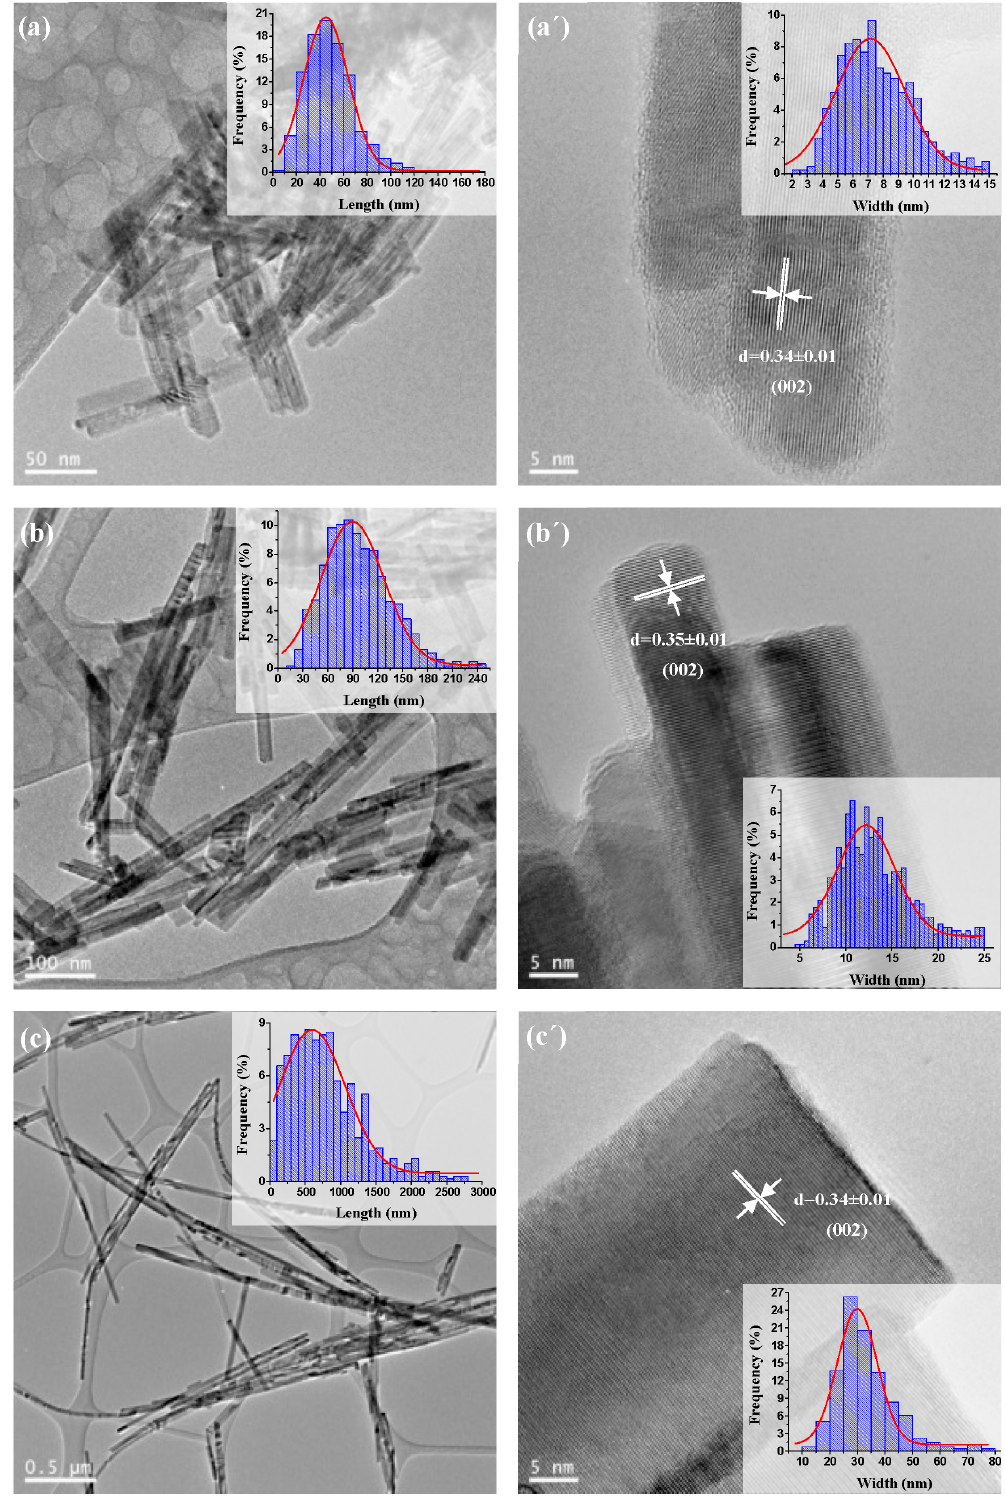
Figure 5. TEM and HRTEM images and size distribution curves (inset) of CdS samples prepared at different solvothermal temperature: ( a , a’ ) CdS-120; ( b , b’ ) CdS-150 and ( c , c’ ) CdS-190.